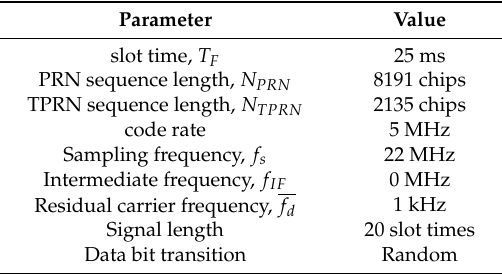
Table 1. Simulation parameters.